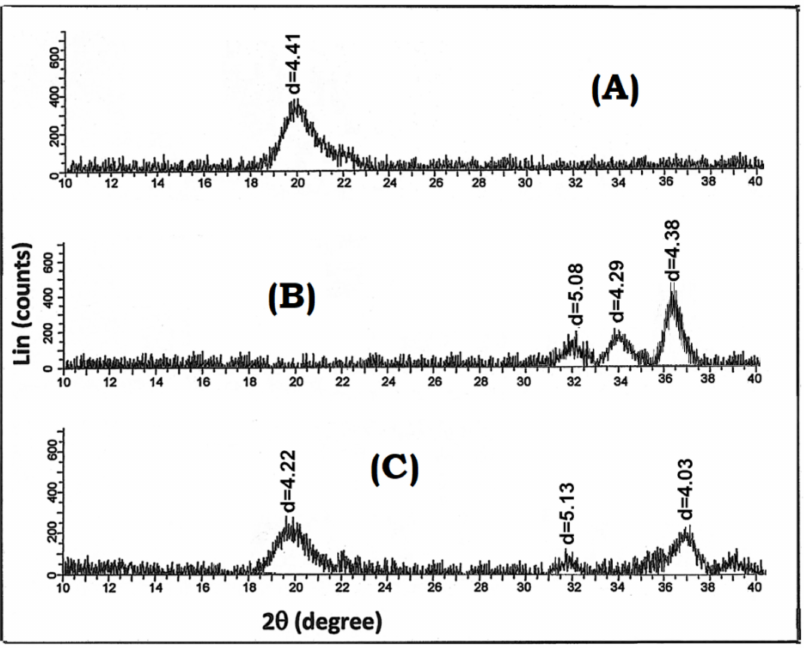
Figure 5. XRD of chitosan ( A ), ZnO nanoparticles ( B ), and 20 wt.% chitosan − ZnO ( C